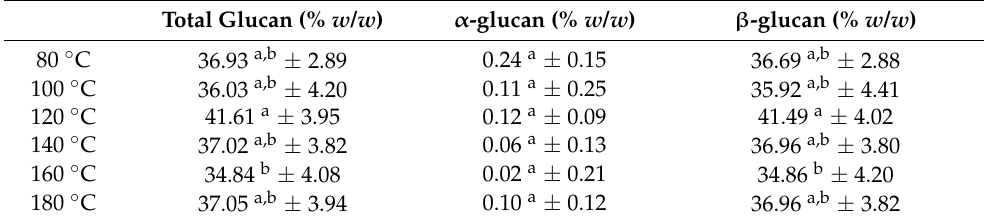
Table 3. Total-, α - and β -glucan contents of shiitake mushroom roasted in different temperatures. Total Glucan (% w/w ) α -glucan (% w/w